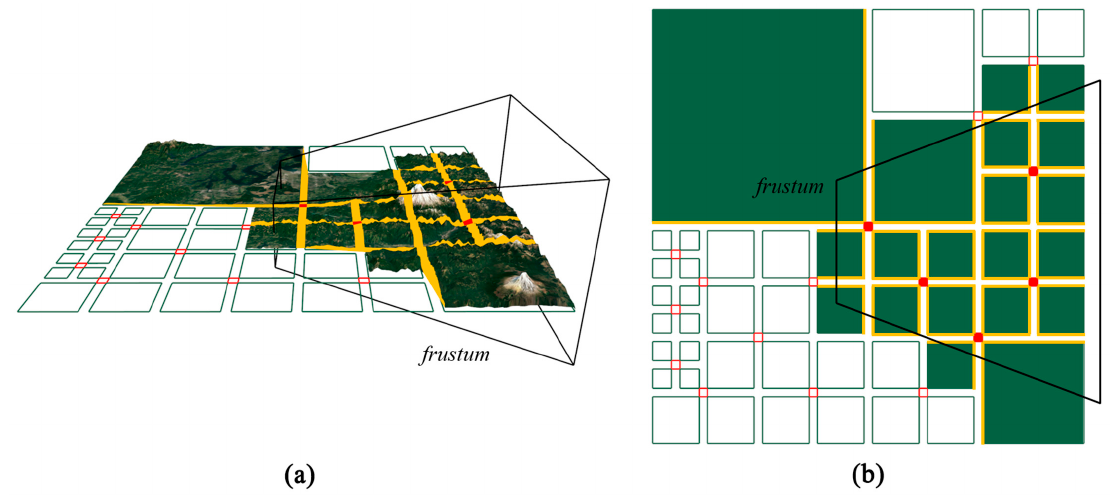
Figure 12. Hierarchical view frustum culling: ( a ) The empty quads are blocks culled by the frustum. ( b ) The yellow segments in the frustum represent the block edges that are used to generate DSSs.